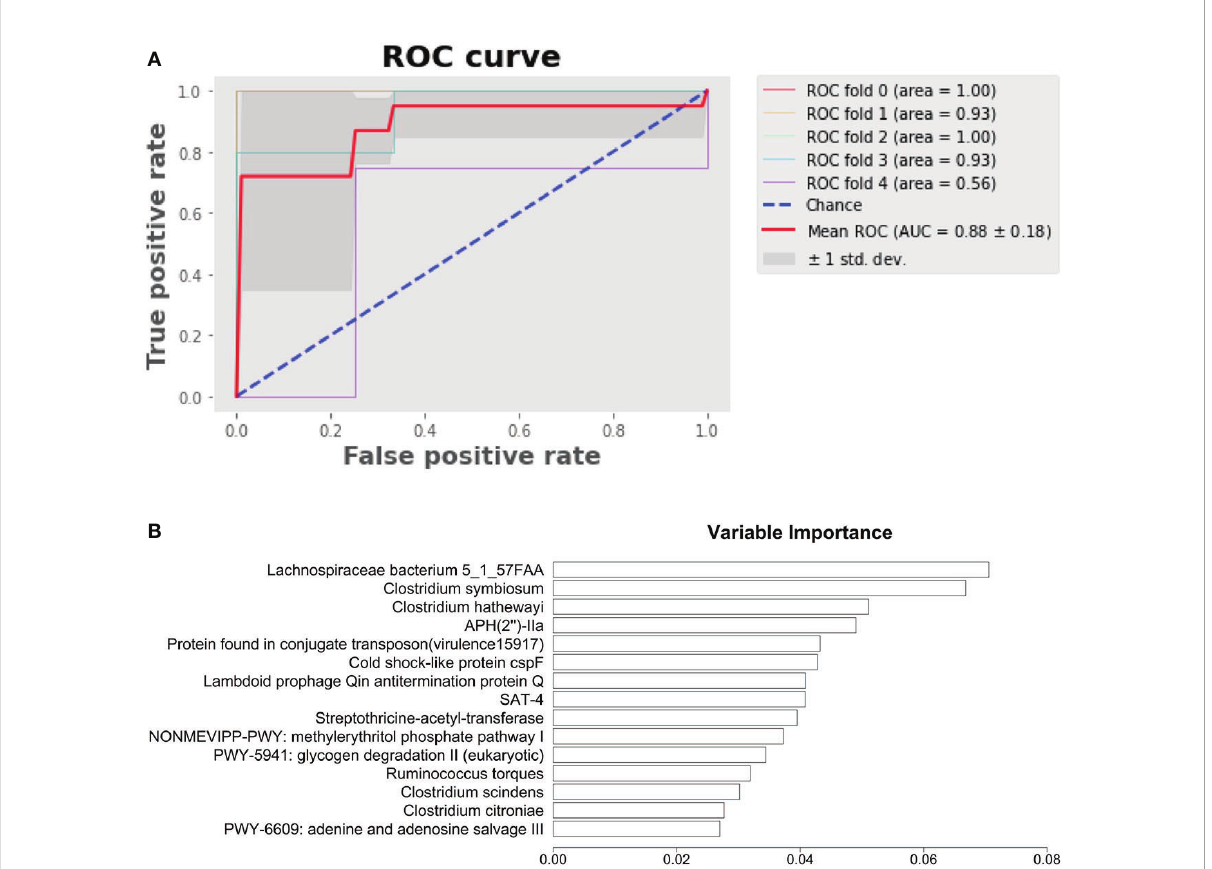
FIGURE 5 Prediction of HD patients with random forest model. (A) Random forest model predicting HD patients from control subjects. (B) Variable